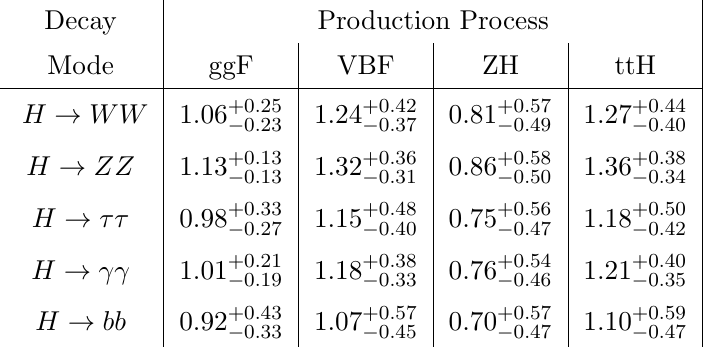
Table 3 . ATLAS results for the 13 TeV data, ref.